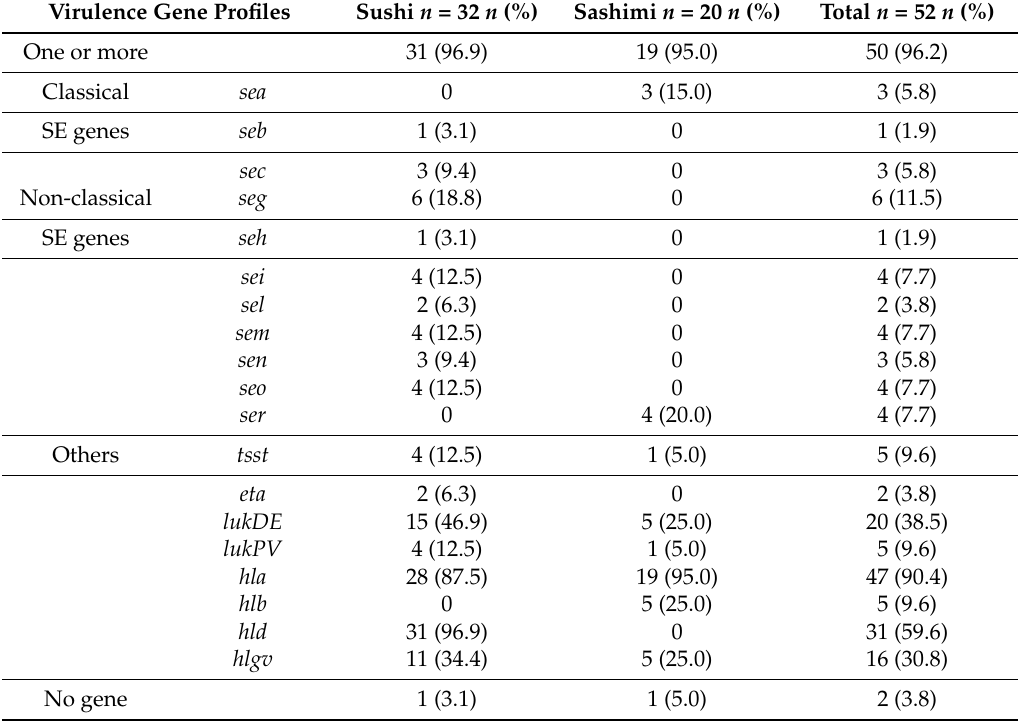
Table 1. Prevalence of virulence genes in 52 Staphylococcus aureus isolated from sushi and sashimi samples. Virulence Gene Profiles